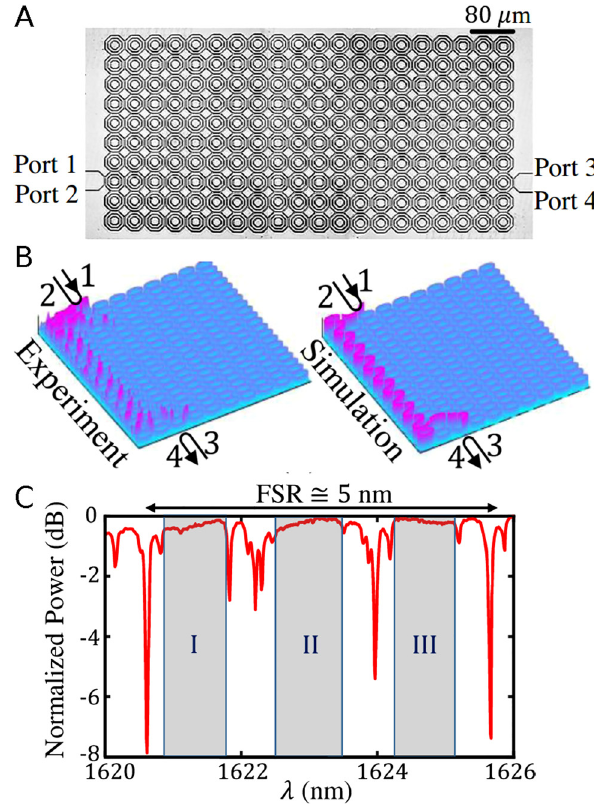
Figure 4: Anomalous Floquet topological resonator lattice, adapted fromthestudybyAfzaletal.[83].(A)Microscopeimageofthesilicon resonator lattice. (B) Image of scattered light when the chiral edge state is excited (left), compared with the simulated edge state intensitydistribution(right).(C)Measuredtransmissionspectrumof the lattice, with high transmission in all three band gaps (shaded grey regionsI, II, III) mediated by the anomalous Floquet topological edge